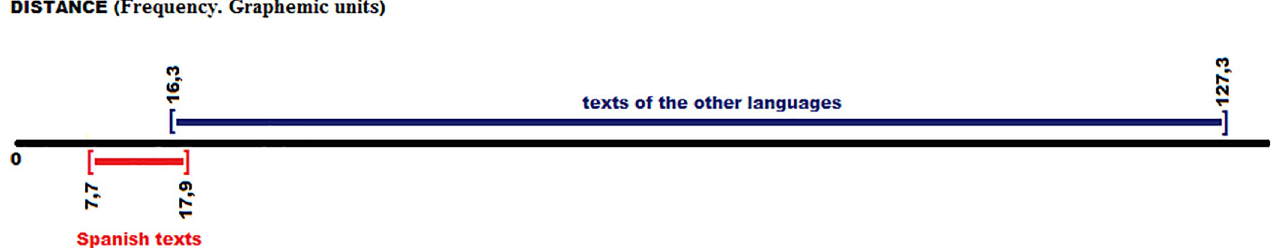
Fig 9. Distances between the Spanish or Castilian (average value) with all the texts of all the languages (graphemic